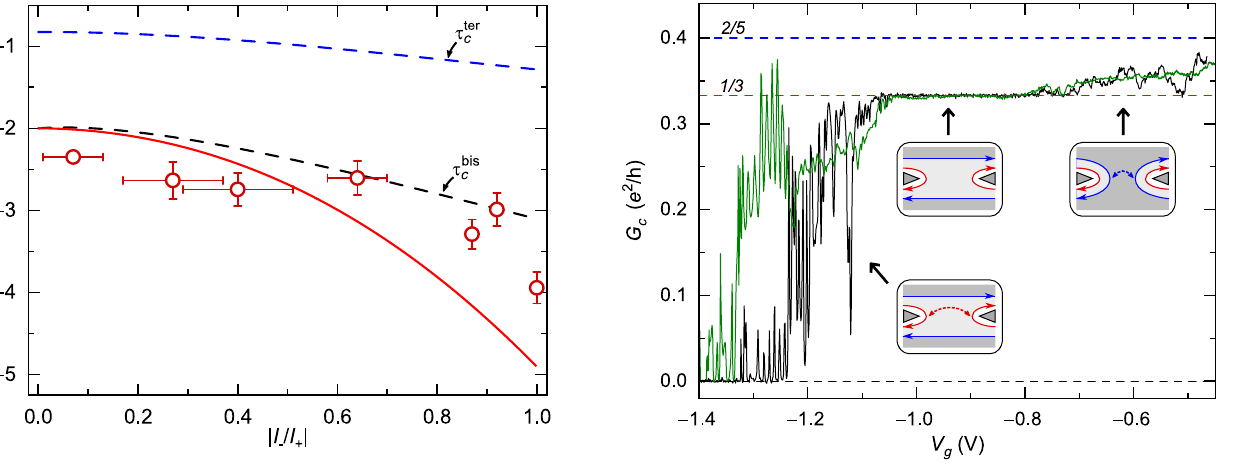
FIG. 6. Differential conductance G through the analyzer QPC c c at ν ¼ 2 = 5 as a function of the applied gate voltage V (detailed g features may vary with overall device configuration). The black and green continuous lines display measurements, respectively, in 0 ) and in the presence V 0 V the absence of a dc bias ( V t ¼ t ¼ b ¼ − 90 μ V, V 0 ). The V 0 of a direct dc voltage bias ( V t ¼ t ¼ b ¼ > e 2 = 3 h , when the inner (outer) edge channel dependence at G c is partially (fully)